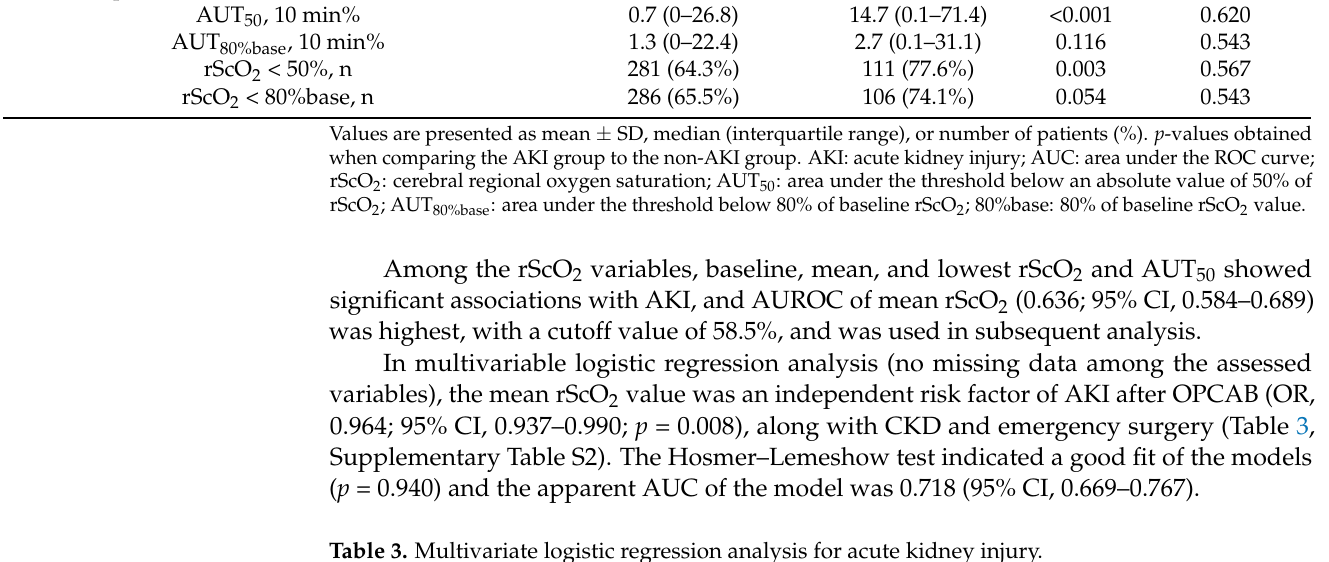
Table 3. Multivariate logistic regression analysis for acute kidney